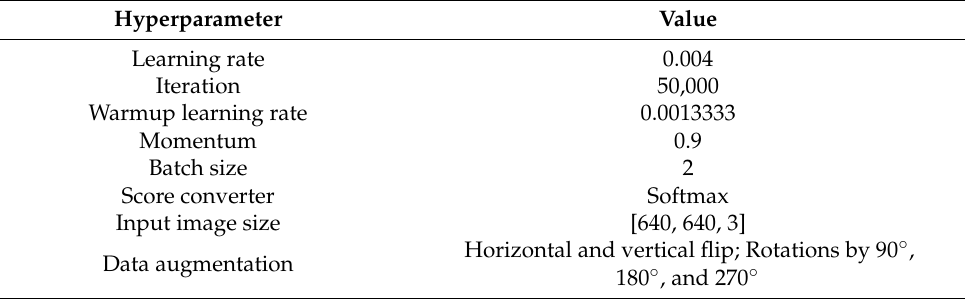
Table 3. Hyperparameters selected for the training of the Faster R-CNN